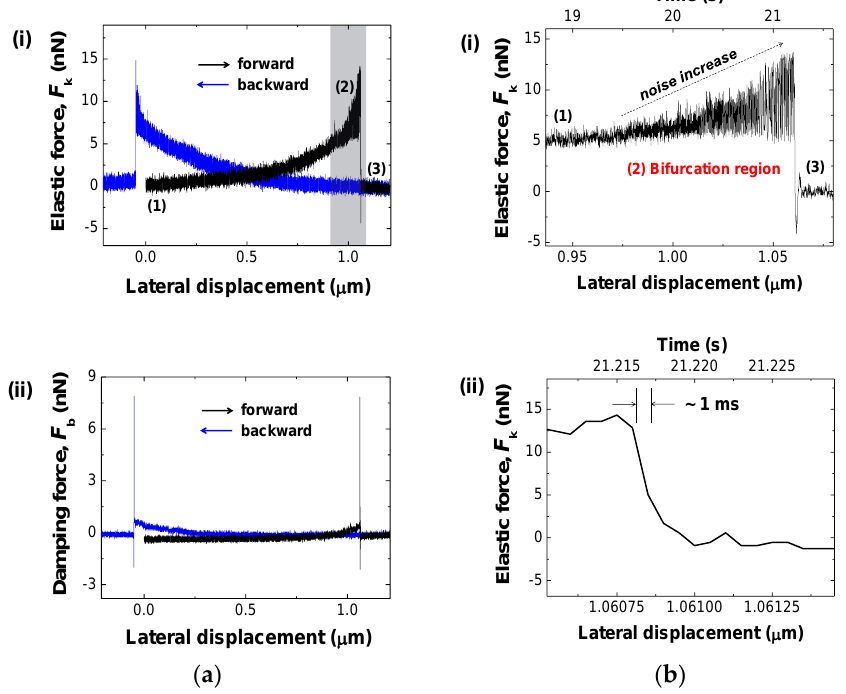
Figure 2. Instability-induced flipping of buckling cantilever by lateral movement: ( a ) during lateral movement of 1 μ m distance (for duration of ~22 s at the tip speed of 50 nm/s), the tip experiences accumulated flexural forces and the resulting enhancement of non-linear fluctuations triggers random switching of the buckling direction with decrement of potential wall. The continuous accumulation of the forces results in the corresponding increment of the Elastic force ( F k -(i)) and damping force ( F b -(ii)) in the frequency modulation (FM) detection of a QTF-based atomic force microscope (AFM); ( b ) magnified gray area of ( a ). (i) The tip with a given initial buckling (1) experiences increment of forces until it reaches the bifurcation region by lateral movement (2), and within the region of enhanced non-linear fluctuations, the tip flips abruptly accompanying recovery of the initial frequency but with the buckling direction reversed (3). (ii) Fast time-resolved mechanical responses resulting from abrupt flipping (~1 ms in 0.2 nm distance) are observed.